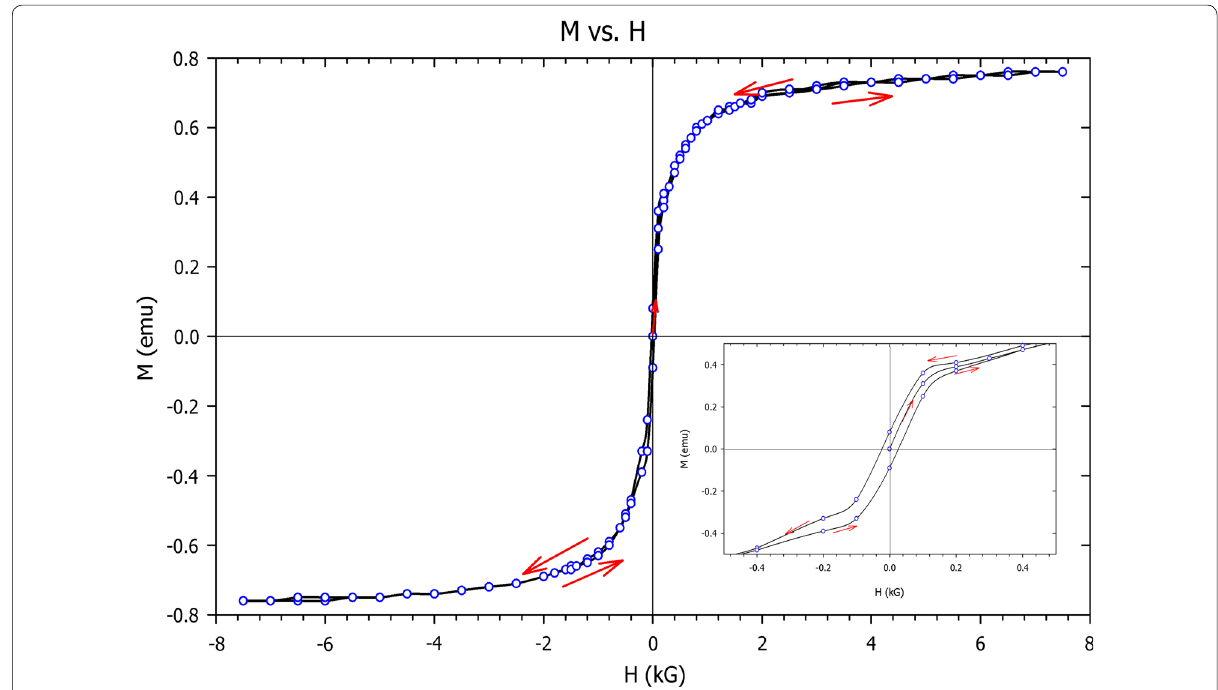
Fig. 2 VSM result of naked Fe 3 O 4 /SiO 2 /TiO